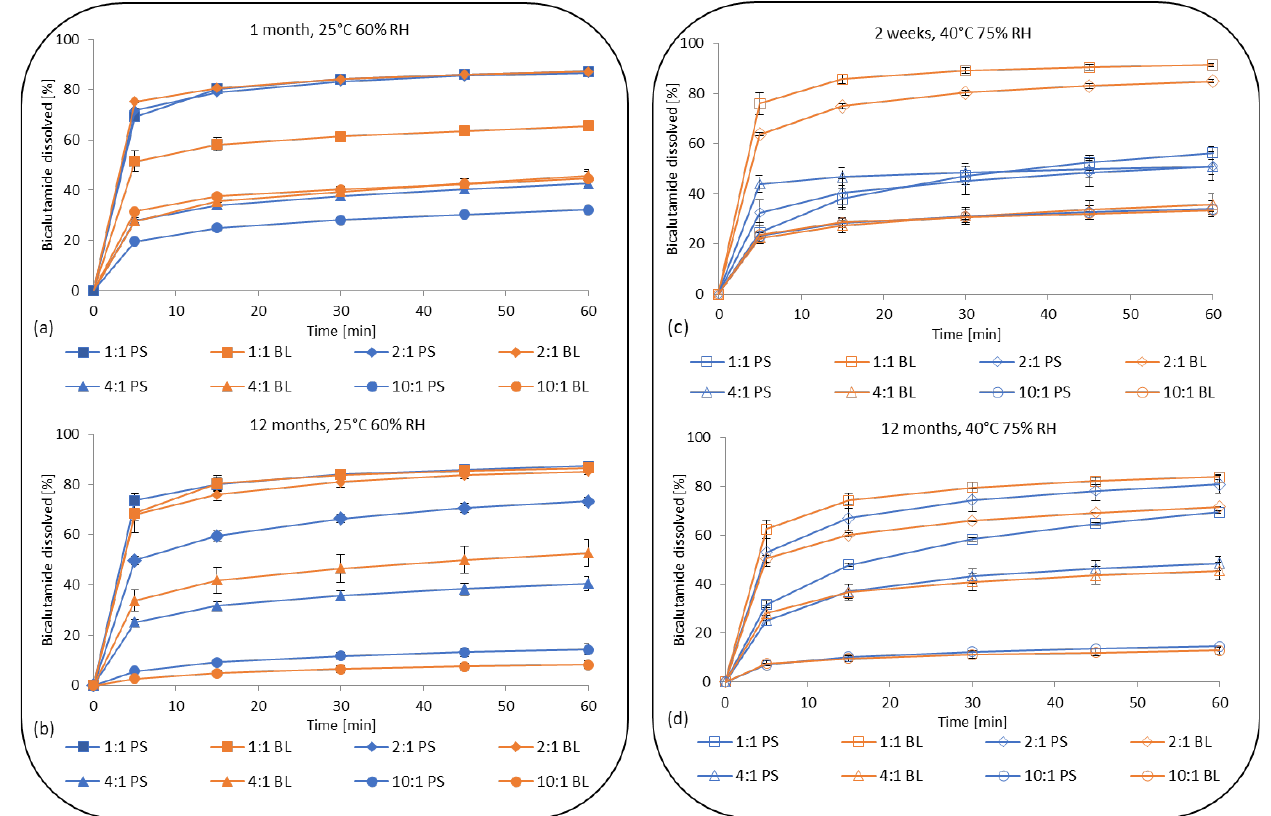
Figure 5. Dissolution of bicalutamide from the 1:1, 2:1, 4:1, 10:1 solid dispersions packed into PVC/Al blisters (BL) and polystyrene bag (PS) after storage in long-term conditions (25 °C/60% RH, left panel) for 1 month ( a ) and 12 months ( b ), and accelerated conditions (40 °C/75% RH, right panel) for 2 weeks ( c ) and 12 months ( d ); the errors bars represent the standard deviation.